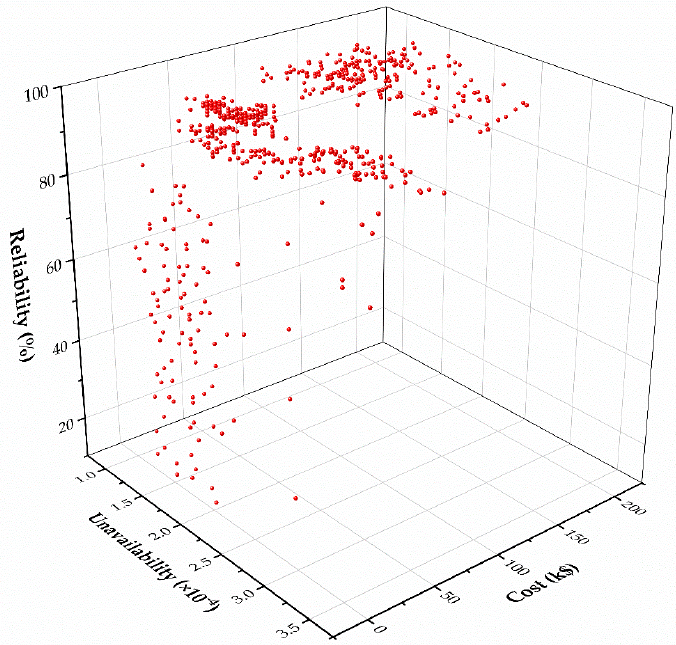
Figure 4. The 3D space of non-dominated solutions for multi-objective functions.